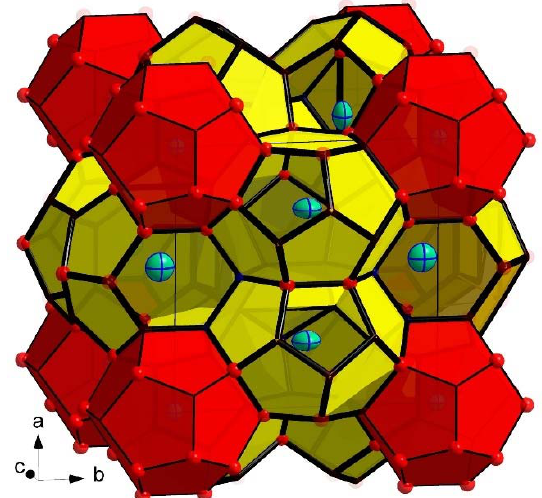
Figure 1. Schematic view of the primitive ‐ centered cubic clathrate type ‐ I structure (space group Pm 3 n ). Color coding for the electronic version of the paper: pentagonal dodecahedra are red (darker), tetrakaidecahedra are yellow, and guest atoms are blue.